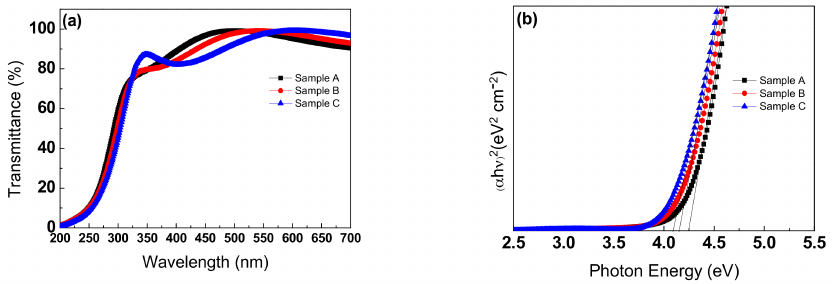
Figure 2. ( a ) Transmittance spectrum of Samples A, B, and C. ( b ) absorption coefficient versus photon energy for these three samples.